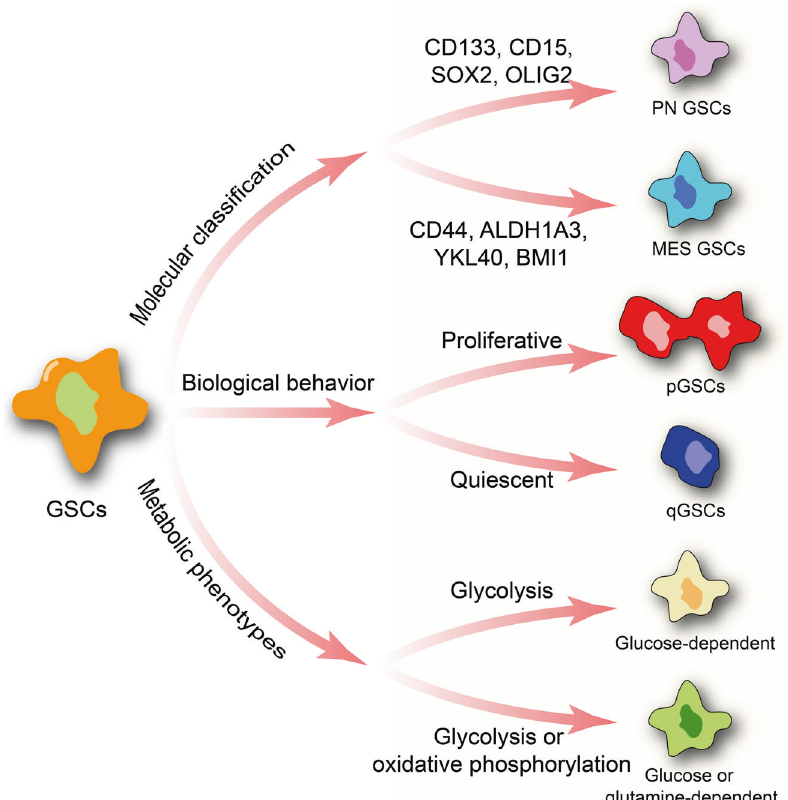
Fig. 1 GSCs classi fi cation based on molecular signatures, metabolic phenotypes and biological behavior. The molecular classi fi cation includes PN GSCs and MES GSCs. Two metabolic phenotypes of GSCs are identi fi ed. The former mostly dependent on glycolysis. The latter metabolizes glutamine to supply OXPHOS but it can switch to glycolysis when glutamine is insuf fi cient. According to biological behavior, GSCs can be grouped into proliferative GSCs and quiescent